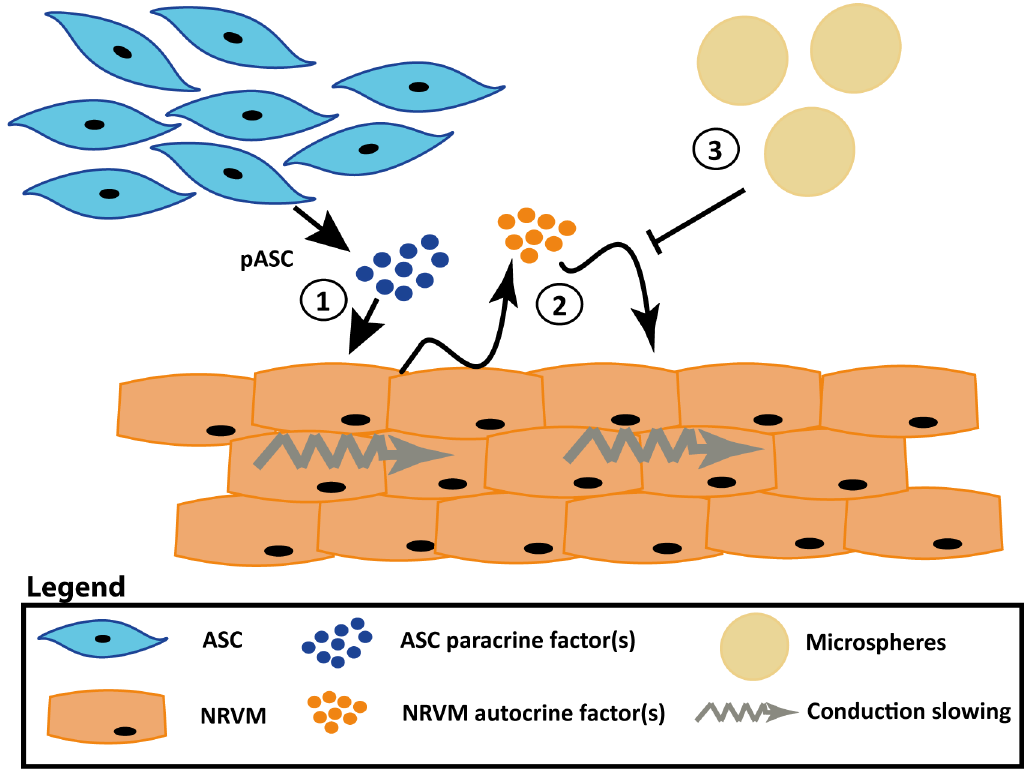
Fig 10. Schematic illustration of how the recombinant human collagen-based microspheres mitigate the conduction slowing induced indirectly by porcine adipose tissue-derived stromal cells. ( 1 ) pASC secrete (a) paracrinefactor(s) that induceNRVM to produce(a) secondary autocrinefactor(s) that is responsible for the observed heterogeneous conductionslowing( 2 ). When the microspheres are added to monolayers of NRVM, either bare or loadedwith pASC, the secondary autocrinemyocardial factor is buffered by the microspheres and the conduction slowingis mitigated( 3 ). Abbreviations; NRVM: neonatalrat ventricular myocytes and pASC: porcineadiposetissue- derivedstromal